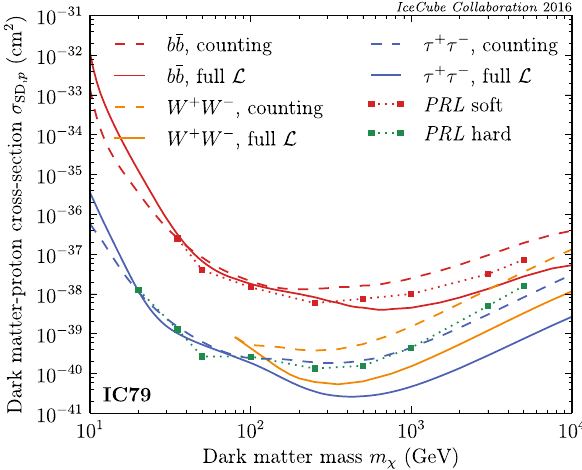
Fig. 25 Improvement on the dark-matter proton cross section due to the use of an event-level likelihood analysis (full lines) compared to a traditional cut-and-count analysis (dashed lines) and an analysis based on the difference in shape of the space-angle distribution for signal and background (dotted lines tagged ‘PRL’ and originally from [236]). 100% annihilation to b b , W + W − and τ + τ − is assumed in each case shown. Figure from